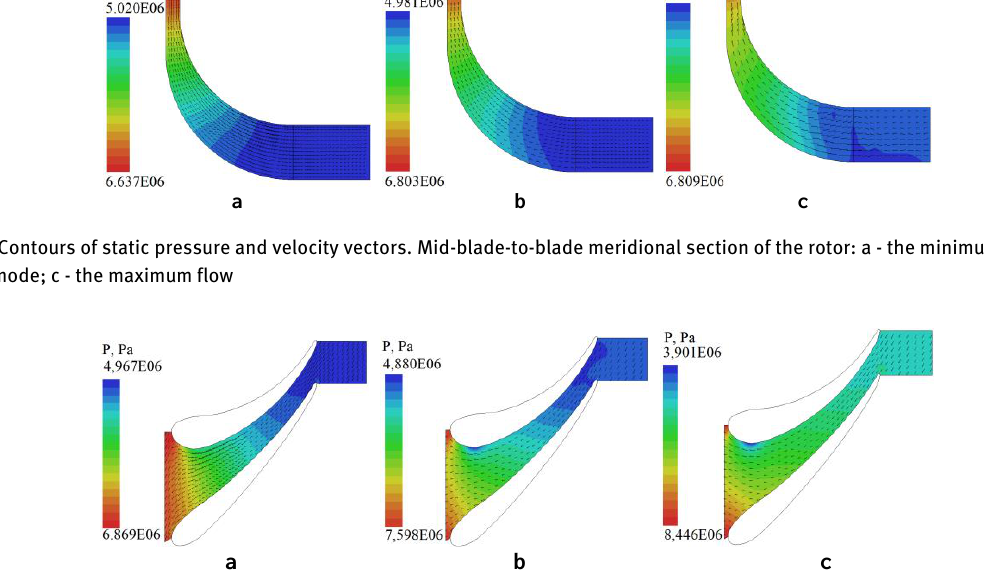
Figure 7. Contours of static pressure and velocity vectors. Mid-span blade-to-blade section of the rotor: a – the minimum flow; b - the nominal mode; c - the maximum flow